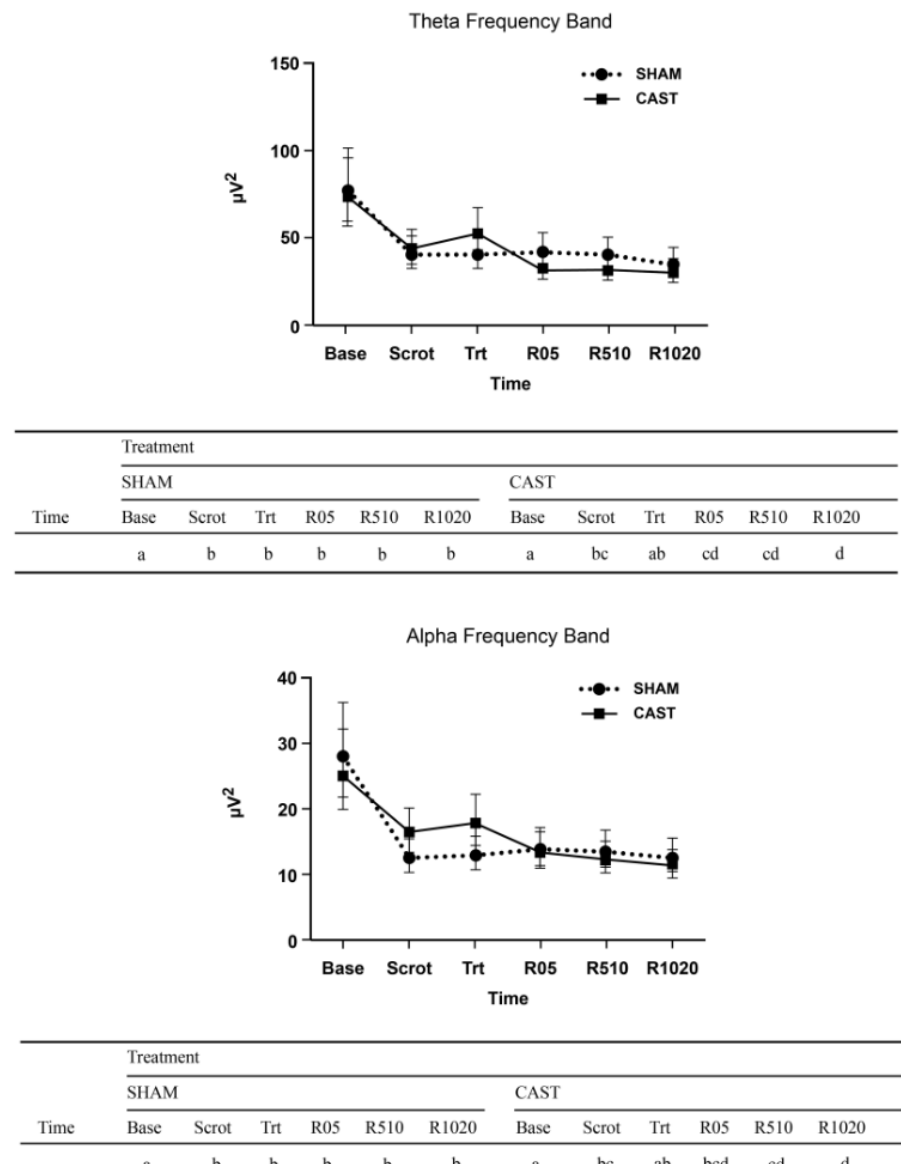
Figure 2. Estimated least-square means and 95% confidence intervals of absolute power ( µ V 2 ) of theta and alpha frequency bands for 6-week—(6W), 3-month—(3M) and 6-month-old—(6M) calves undergoing simulated castration (SHAM) and surgical castration (CAST) treatments. Timepoints evaluated consist of baseline (Base), scrotum manipulation (Scrot), treatment (Trt), immediate recovery (R05), middle recovery (R510), and late recovery (R1020). The letters (a, b, c, d) indicate a significant difference ( p < 0.05) between time points within a given treatment after accounting for age effects.